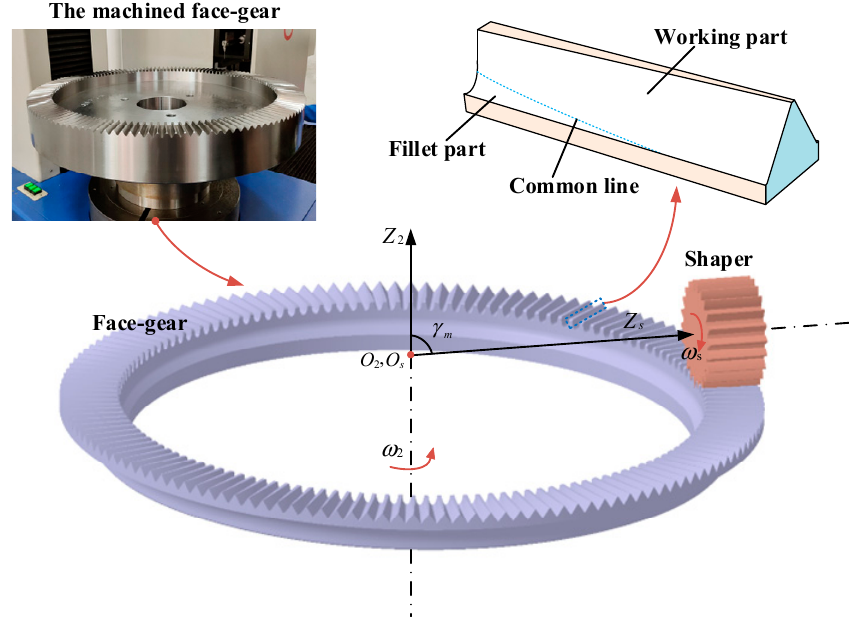
Figure 1. Modeling Process of Face Gear Machining by Spur Gear Tool.